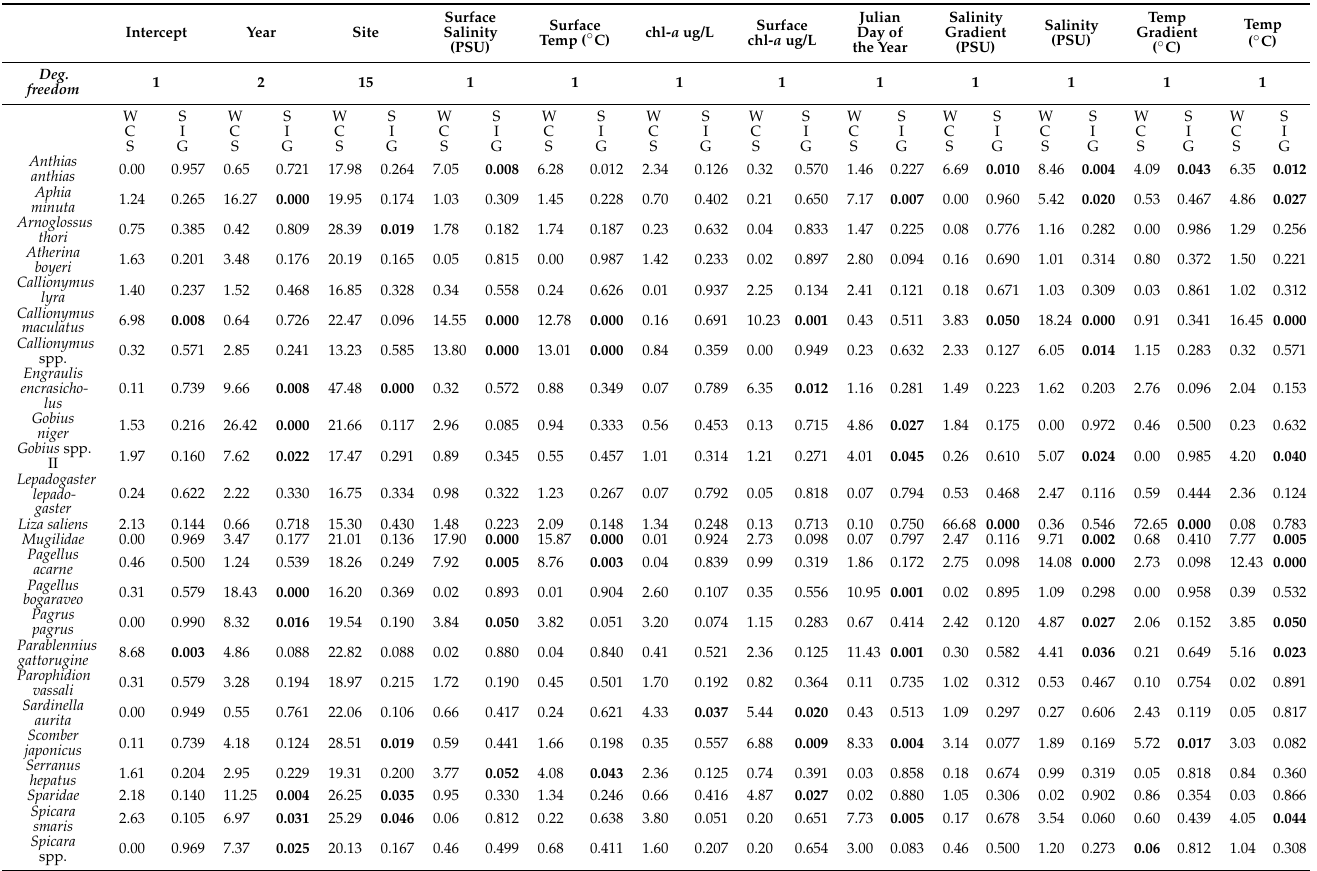
Table 4. Generalized linear modeling results for the 24 most abundant species and taxa of ichthyoplank- ton sampled at field sites in the outer Thermaikos Gulf of the Aegean Sea offshore of the coastal zone of Kitros, in the Pieria region of Greece. SIG = significance values ( p ≤ 0.050 are significant and in